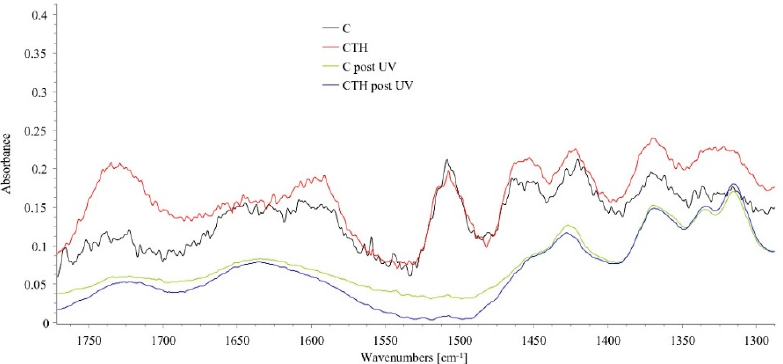
Figure 6. Comparison of FTIR spectra of unmodified and thermally modified cedar wood samples, pre-and post-UV treatment, in the fingerprint region.